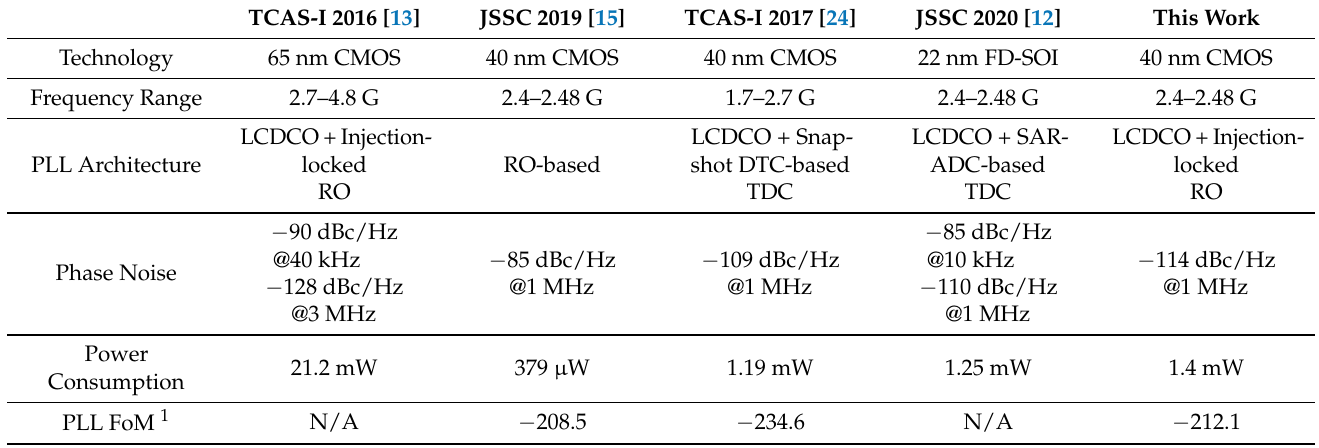
Table 1. Performance comparison with the